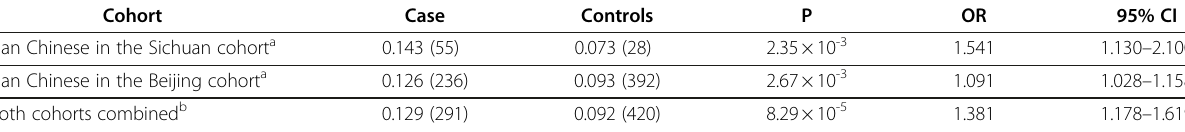
Table 3 A comparison of the frequencies of HLA-DRB1*04 in primary IgAN patients and healthy controls of different